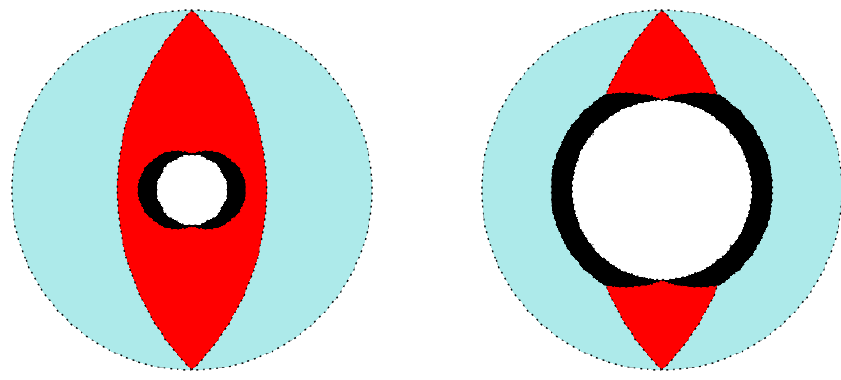
Figure 10 . Phase diagram for annulus with supercritical and subcritical L respectively. The point ( x; y ) belongs to one of three regions, depending on whether the RT surface anchored at points f ( x; y ) ; ( (cid:0) x; y ) g is connected (red), disconnected and ending on the inner ETW brane (black), or disconnected and ending on the outer ETW brane (light